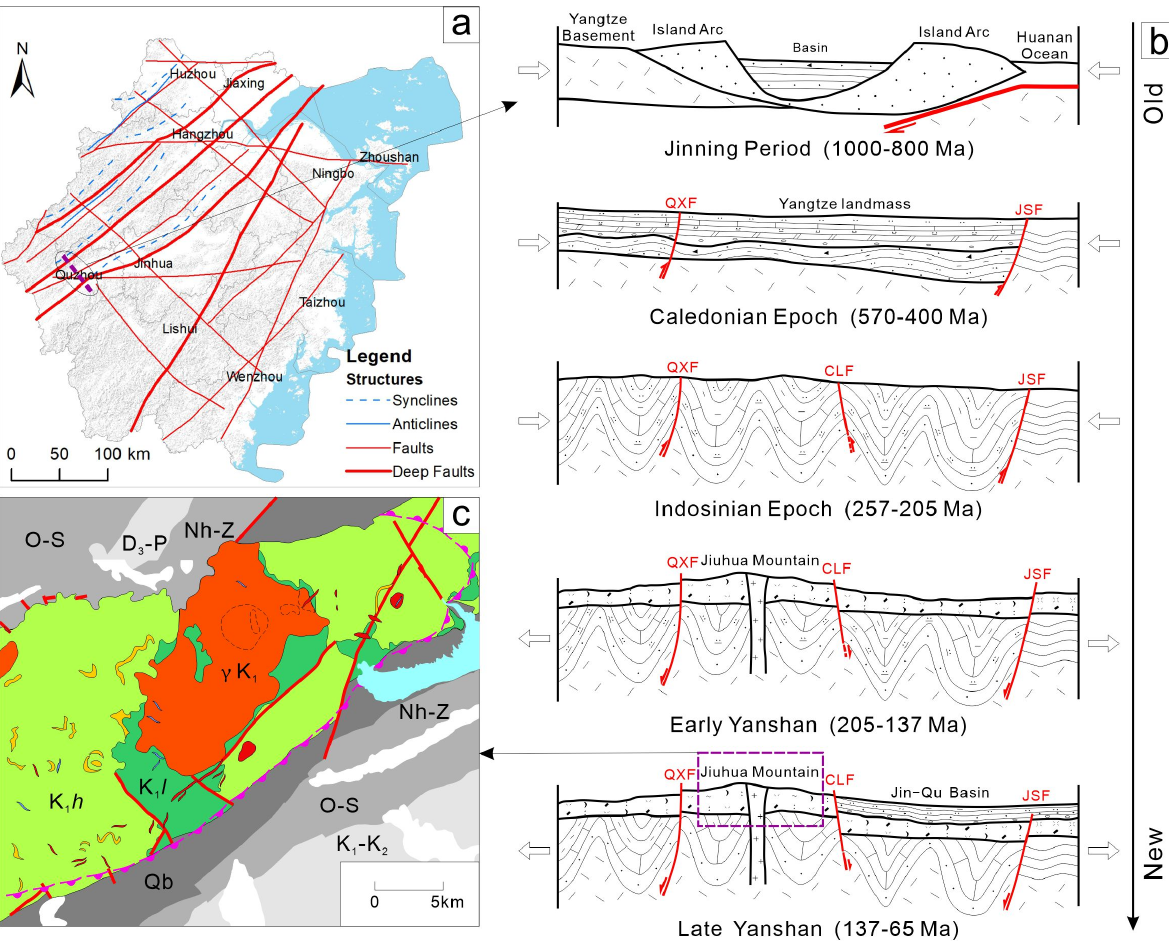
Figure 3. Diagram of regional geological structural evolution. ( a ) Structural outline map of Zhejiang Province. ( b ) Geological structural evolution of Jin-Qu Basin. ( c ) Geological and structural map of Jiuhua Mountain (QXF: Qiuchuan–Xiaoshan Fault).